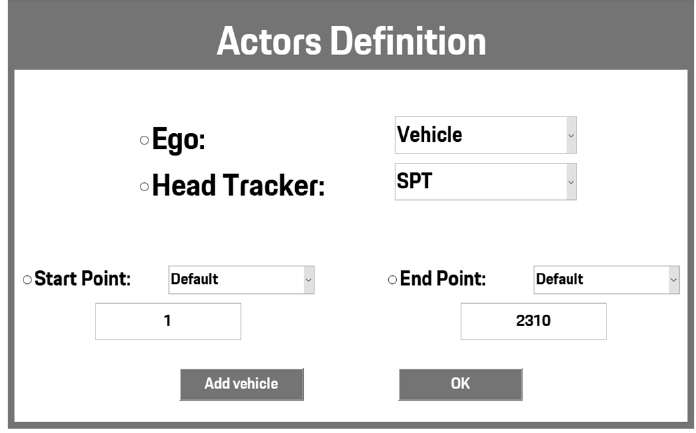
Figure 7. Actors’ definition window.